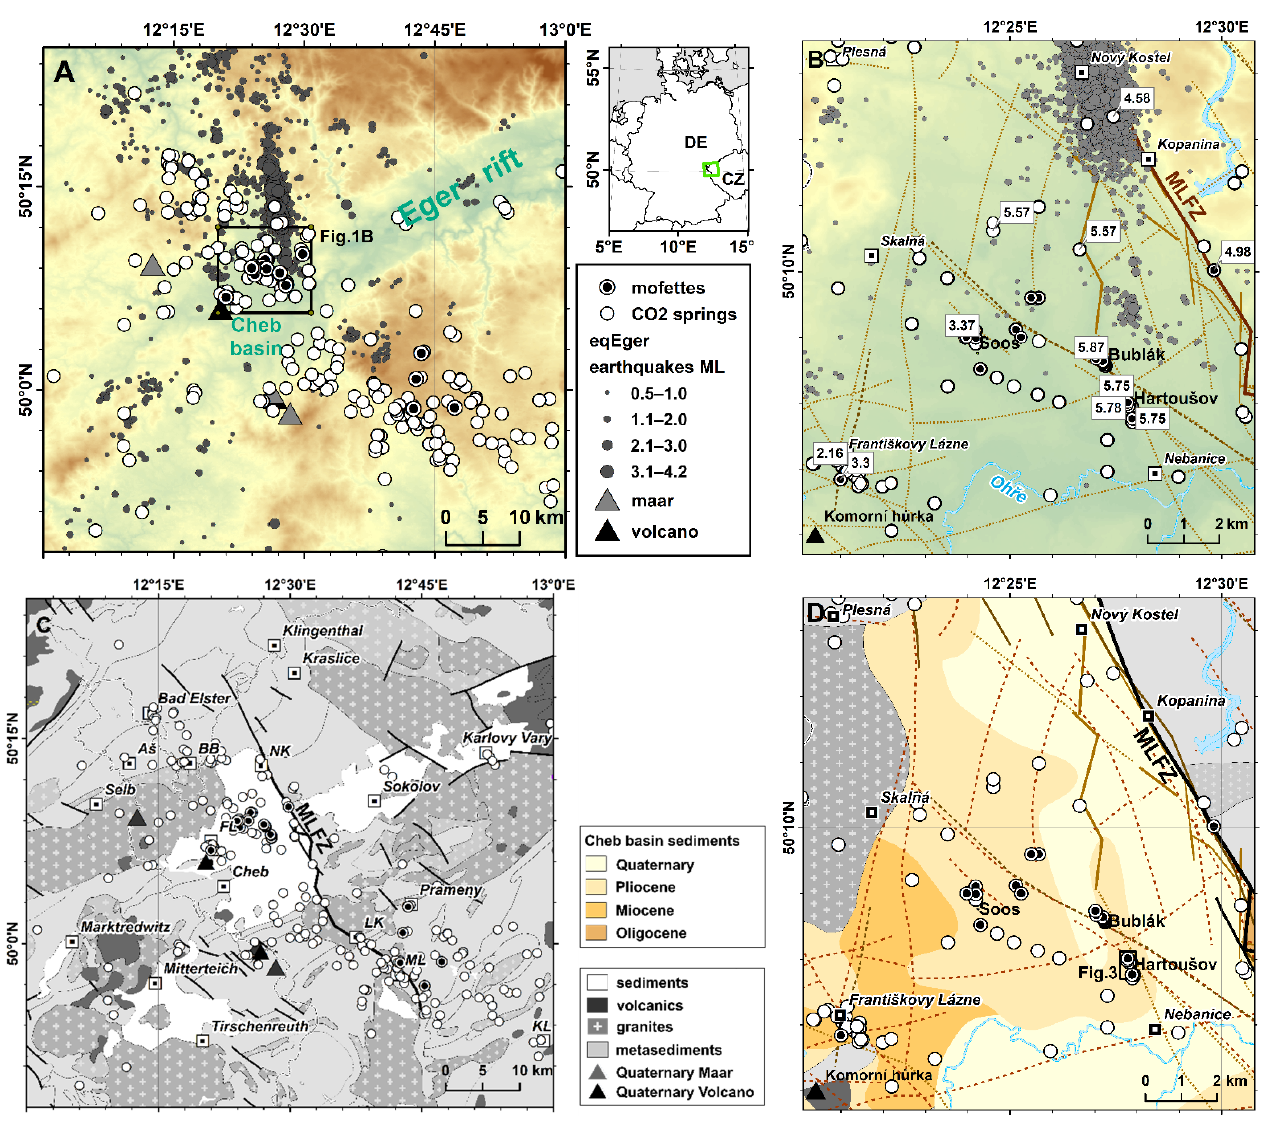
Figure 1. ( A ) Topographic map showing the NW Bohemia/Vogtland region. White circles depict CO 2 -rich mineral waters; filled circles indicate mofettes. Gray dots show earthquakes above M L ≥ 0.5 between 2000 and 2021. ( B ) Mofette fields of Bublák, Hartoušov, and Soos within the Cheb basin. Numbers indicate helium isotope ratios (( 3 He/ 4 He) c in units of R A ) according to [18,21,22]. ( C ) Simplified geological map modified from BGR Hannover black lines—fault zones, MLFZ— Mariánské Lázn ě fault zone. White squares indicate towns: BB—Bad Brambach, NK—Nový Kostel, FL—Františkovy Lázn ě , LK—Lázn ě Kynžvart, ML—Mariánské Lázn ě , KL—Konstantinovy Lázn ě . ( D ) Geological map of the Cheb basin.